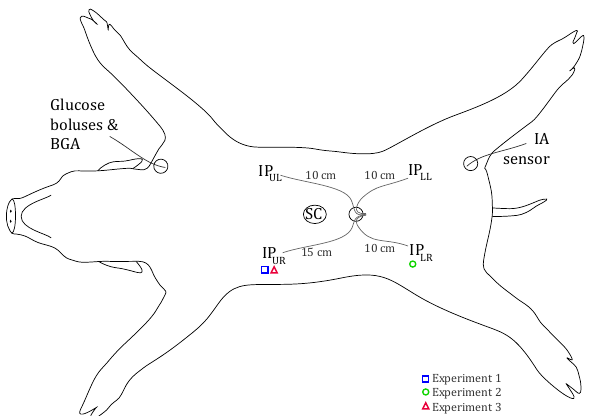
Figure 2: Approximate sensor placement and other in- strumentation on the animal (BGA = blood gas analysis; IP = intraperitoneal; IA = in- traarterial; SC = subcutaneous, UL = up- per left quadrant, UR = upper right quad., LL = lower left quad., LR = lower